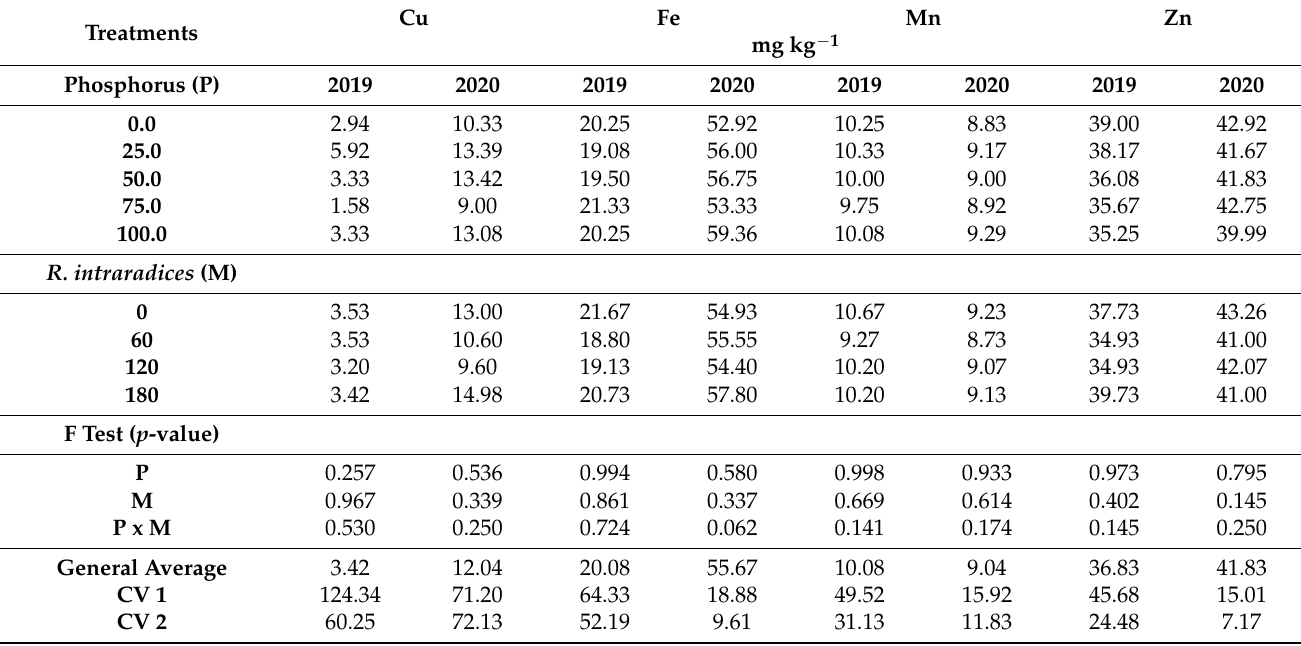
Table 5. Micronutrient contents in harvested corn grain as a function of P 2 O 5 doses and seed inoculation with Rhizoglomus intraradices